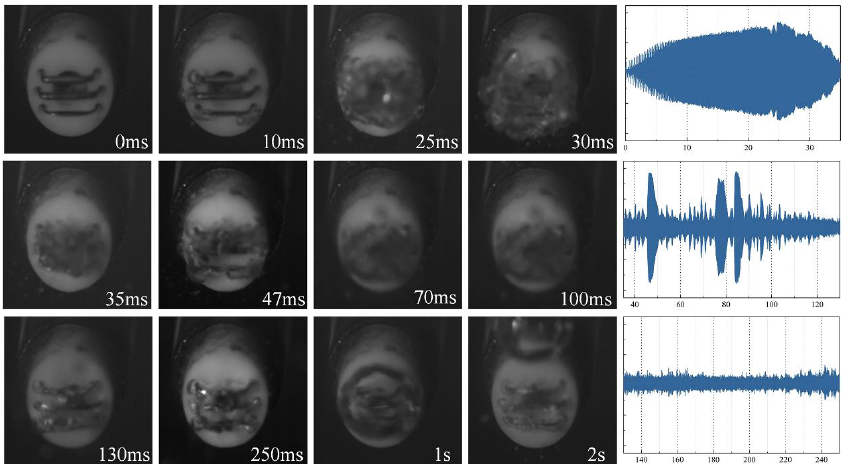
Figure 5. Vaporization dynamics of the plasma scalpel. On the right is the current waveform of three stages. Reproduced with permission from Ref. [8]. Copyright (2020) IOP Publishing, Ltd.